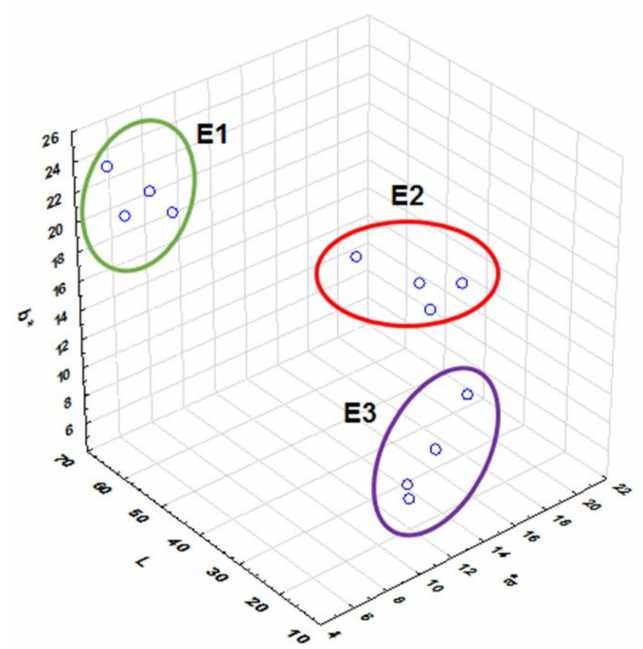
Figure 2. Color coordinates (method CIE L*a*b*) of four blackberry cultivars for three-maturity-stage fruits.E1 (E1-25%), E2 (E2-50%) and E3